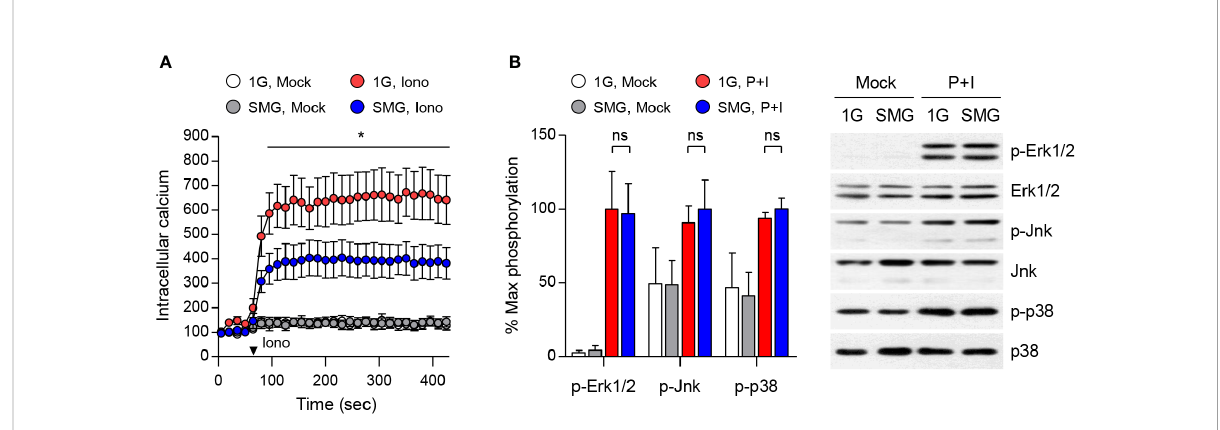
FIGURE 5 Effects of SMG on calcium in fl ux and MAPK signaling. (A) After exposure to either 1G or SMG, BMMCs loaded with FluoForte calcium binding dye were treated with 250 ng/ml ionomycin (Iono) at the time marked by an inverted triangle. Intracellular calcium levels were visualized by fl uorescence microplate reader for 420 sec. Data are shown as the mean ± SEM of 5 independent experiments. (B) BMMCs exposed to either 1G or SMG were stimulated with P+I for 10 min and the cell lysates were subject to immunoblot assay using the indicated antibodies. Band intensities of p-Erk1/2, p-Jnk, and p-p38 were normalized to their total protein expression and are shown as the mean ± SEM (n = 8 in p-Erk1/ 2; n = 3 in p-Jnk; n = 3 in p-p38). *p < 0.05 by Student ’ s t-test. ns, not signi fi cant.